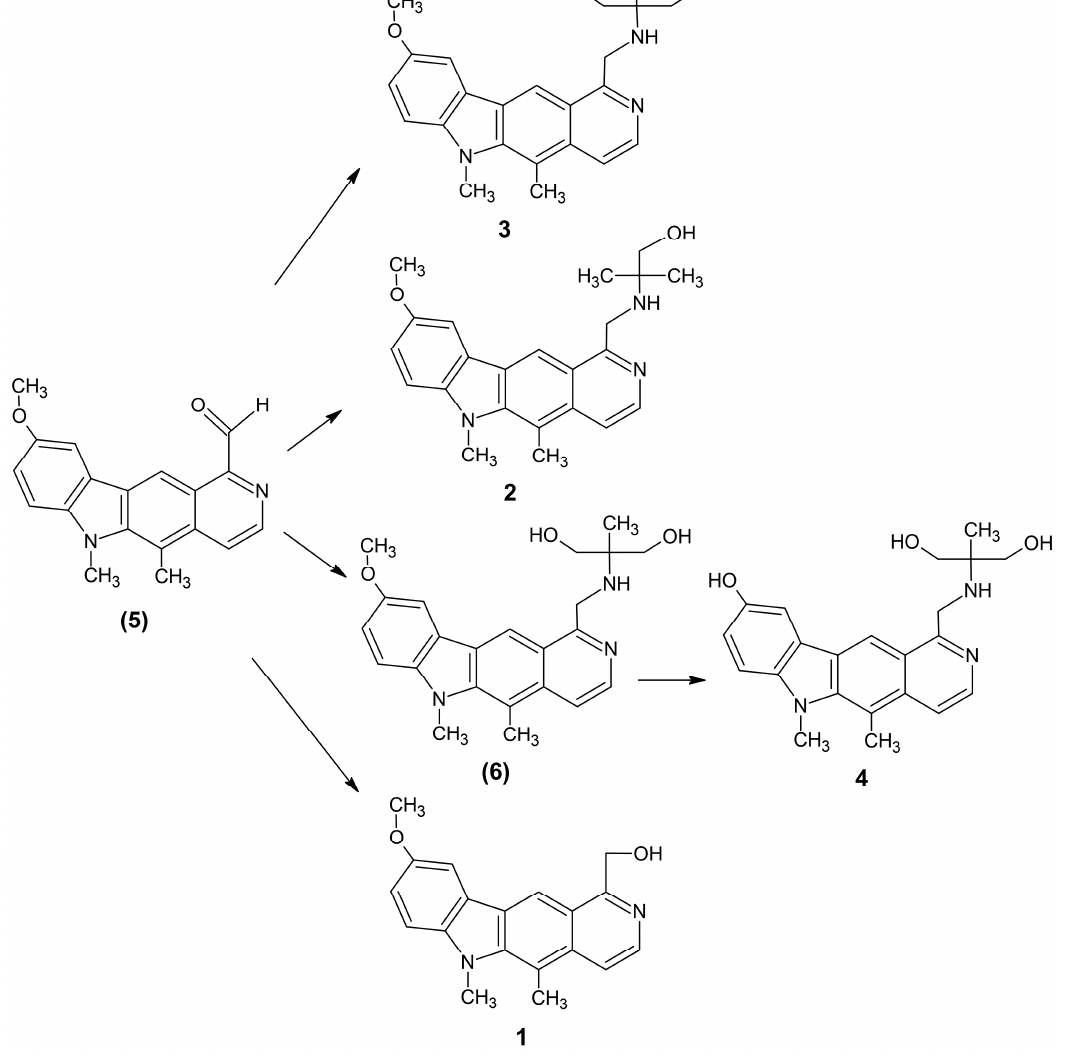
Figure 2. Synthesis scheme of examined olivacine derivatives.